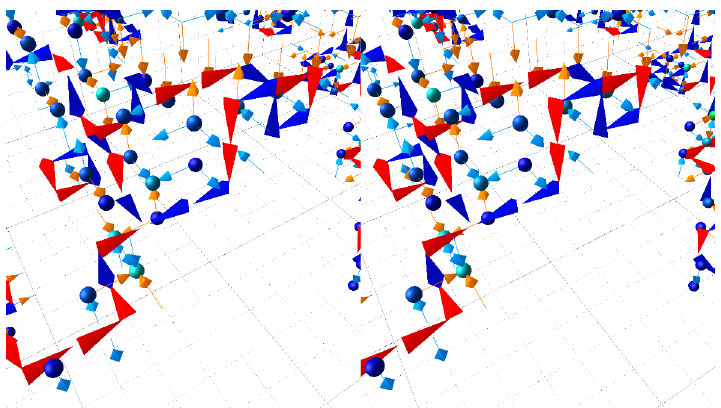
Figure 1. Stereoscopic image of centre vortices as identified on the lattice from Ref. [28]. Vortex features including vortex lines (jets), branching points (3-jet combinations), crossing points (4 jets), indicator links (arrows) and singular points (spheres) are described in the